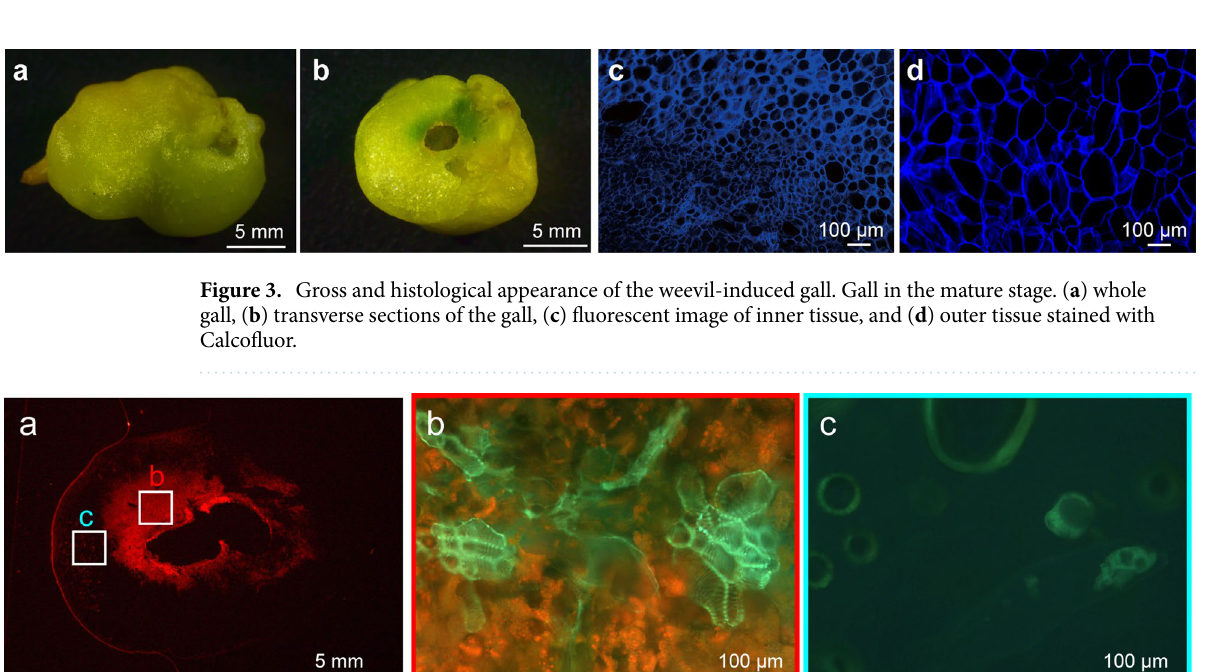
Figure 2. Growth of galls and changes in their appearance. ( a ) The earliest gall at the 1st day, ( b ) growing gall at 7th day, ( c ) 12th day gall just after the escape of weevil, and ( d ) withered gall at 21st day. Bars, 5 mm. ( e ) Changes in the gall size over time. Means ± standard deviations are shown. Sample size is 10. Colours around the images of ( a ), ( b ) and ( c ) correspond to the colours in the graph.